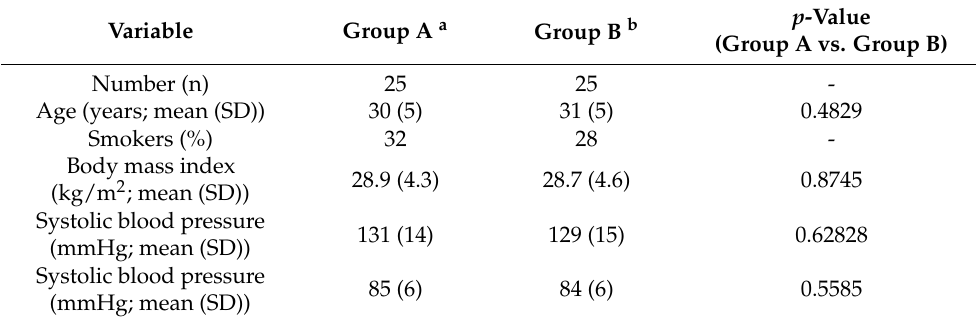
Table 1. Baseline characteristics of